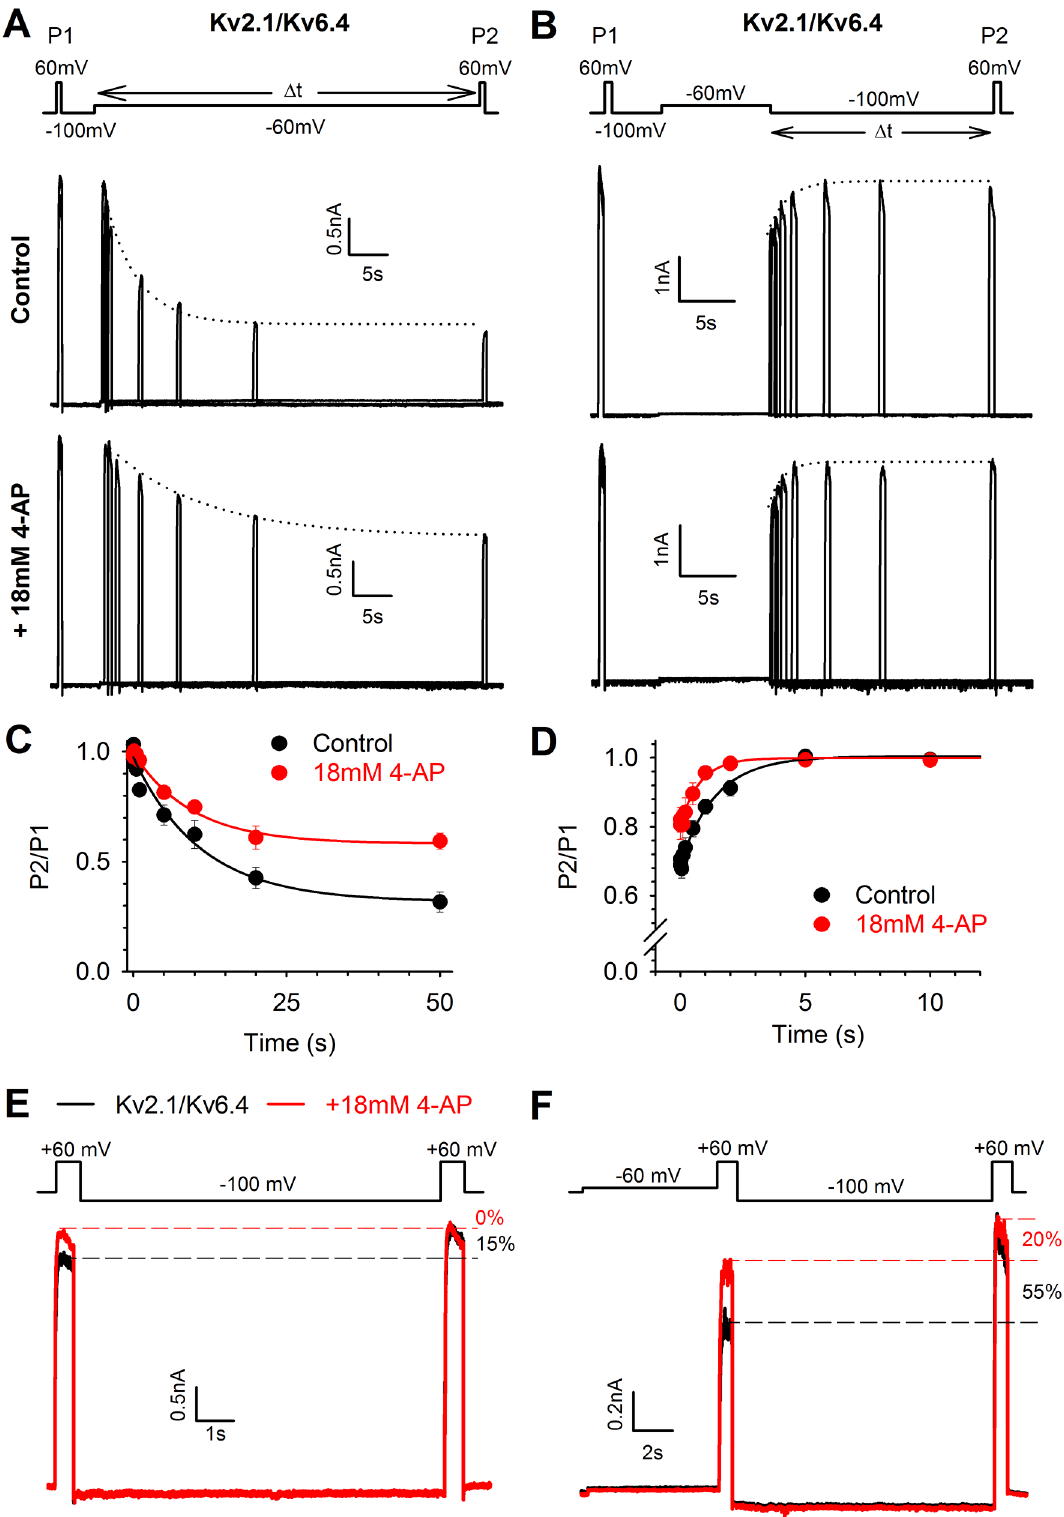
Fig 4. 4 − AP affects closed − state inactivation in Kv2.1/Kv6.4 heterotetramers. (A − B) Representative current recordings in control conditions (upper) and after application of 18 mM 4 − AP (bottom) elicited by the pulse protocol shown in the top to investigate the time course of induction (A) and recovery (B) from